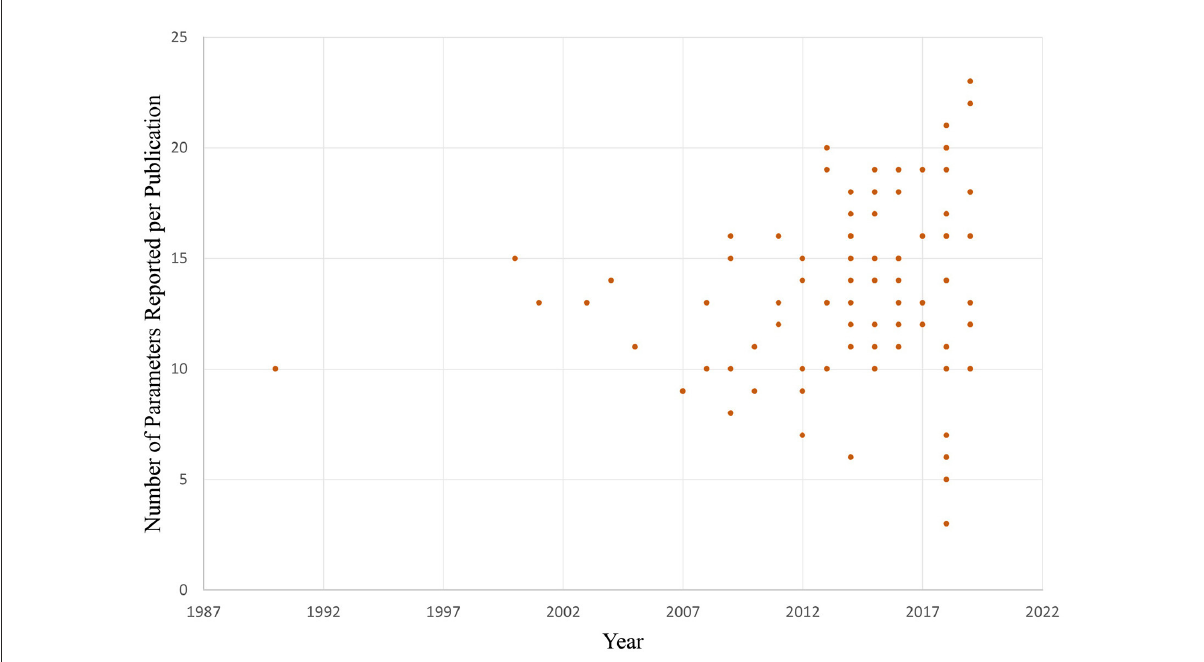
FIGURE2 Number of parameters reported per publication over